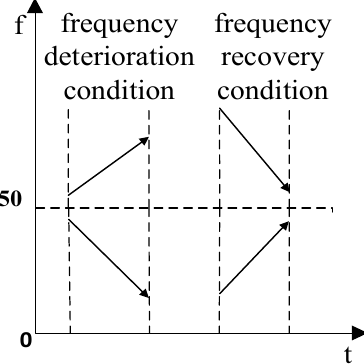
Figure 3. Frequency regulation conditions of energy storage.